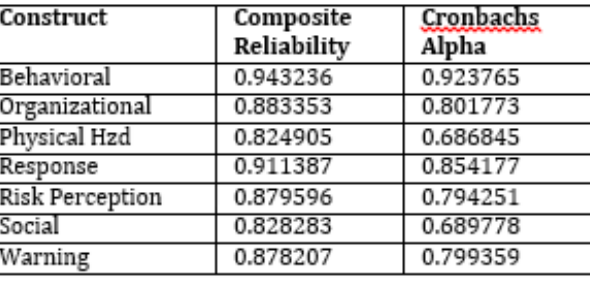
Sekaran & Bougie, 2010).